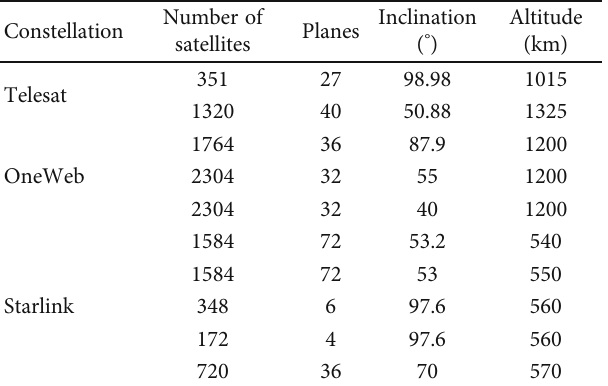
Figure 3: Distribution map of population density with latitude.